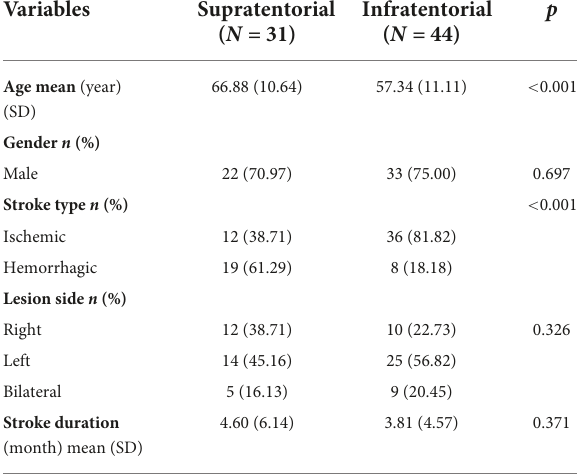
TABLE 2 General characteristics of